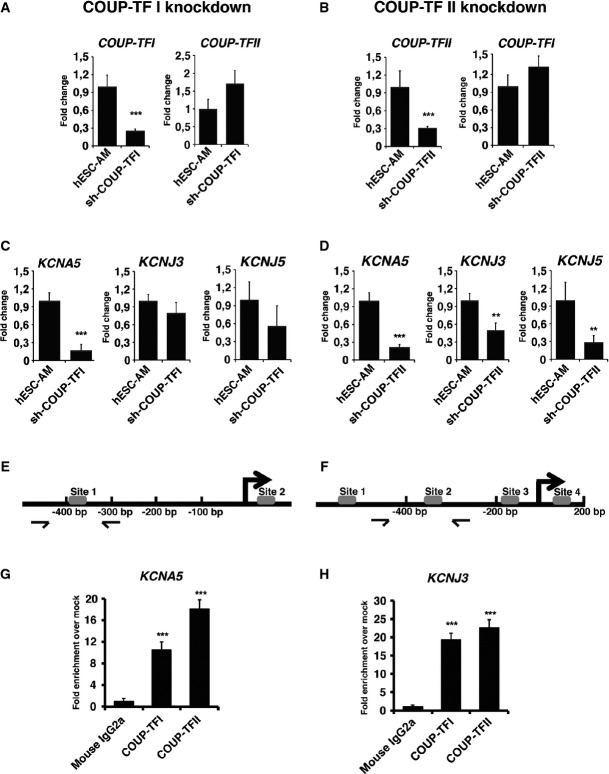
COUP-TFs regulate atrial-specific ion channel genes KCNA5 and KCNJ3
A, B mRNA expression of COUP-TFI and COUP-TFII following shRNA-mediated knockdown of (A) COUP-TFI or (B) COUP-TFII in hESC-atrial cardiomyocytes (AM) at day 30.

C, D mRNA expression of ion channel genes KCNA5, KCNJ3 and KCNJ5 after knockdown of (C) COUP-TFI or (D) COUP-TFII in AM at day 30.

E, F Schematic of NR2F binding sites in (E) KCNA5 and (F) KCNJ3 promoters.

G, H ChIP-qPCR analysis at day 30 shows enriched binding of COUP-TFI and COUP-TFII to the promoter region of (G) KCNA5 and (H) KCNJ3, compared to IgG in AM.

Data information: Data are presented as mean ± SEM. *P < 0.05, **P < 0.01, ***P < 0.001 by unpaired t-test. In (A), P = 0.00004. In (B), P = 0.0001. In (C), P = 0.0001. In (D), P = 0.000004, 0.006 and 0.001, respectively. In (G), P = 0.0004 for COUP-TFI and P = 0.0002 for COUP-TFII. In (H), P = 0.0003 for COUP-TFI and P = 0.0001 for COUP-TFII.